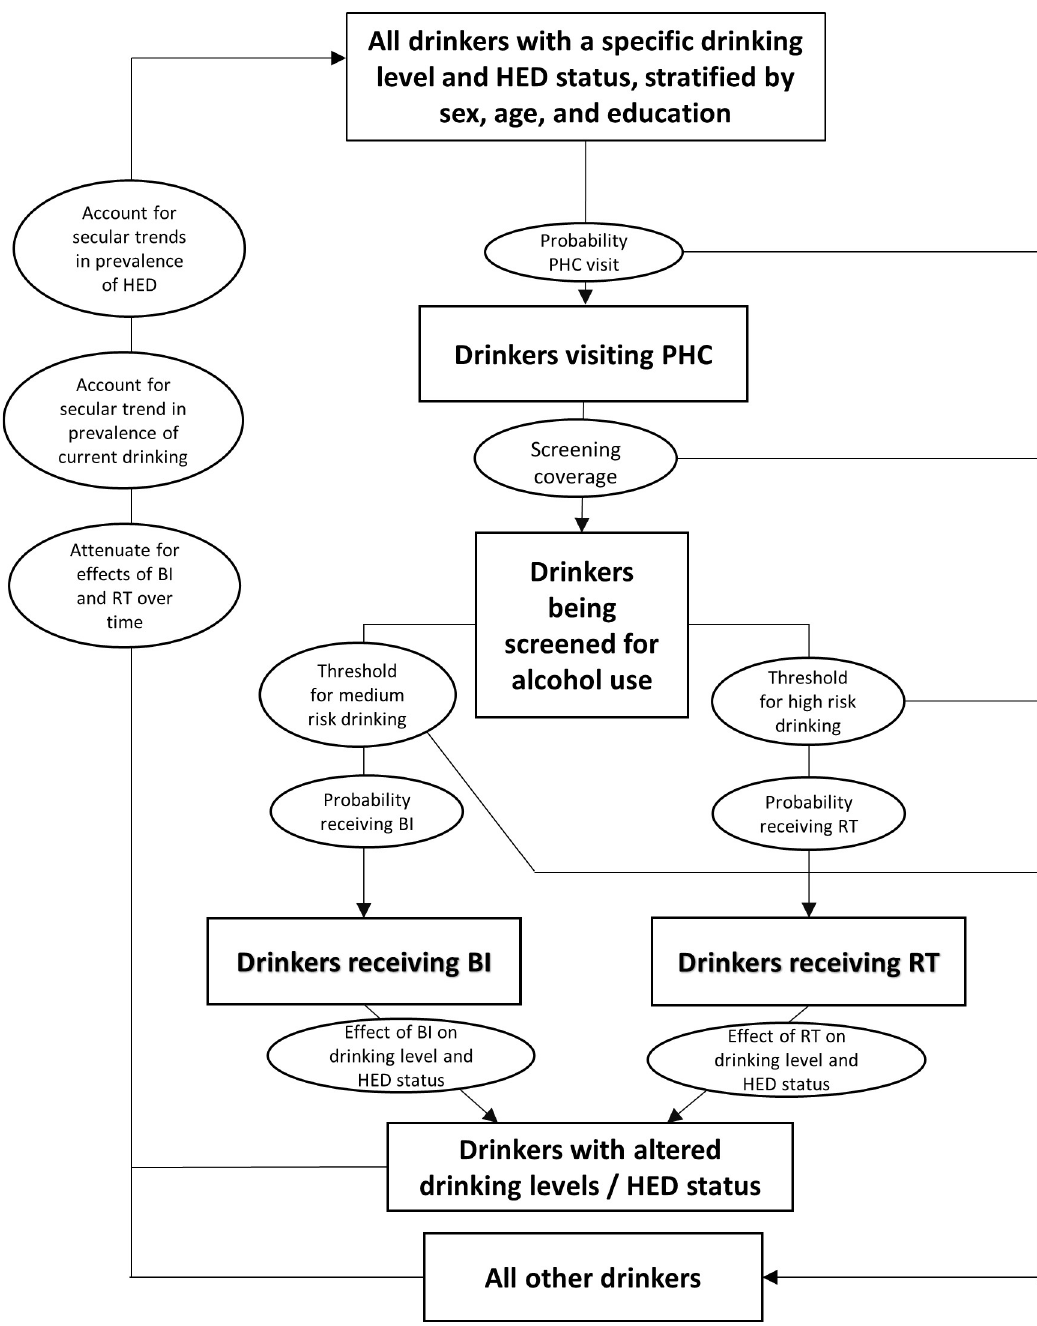
Fig 1. Flow-chart of simulation procedure. Round shapes represent simulation parameters; rectangular boxes represent the sample selected based on specified parameters; the loop repeats every year, for a period of 10 years.